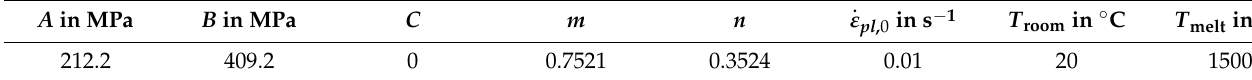
Figure 6. Extrapolated flow curves of HX220 for a plastic strain up to two ( a ); and comparison of the forming force– displacement curves from the experiments and simulation with average displacement at failure u x,fail ( b ). Table 2. Parameters of the Johnson–Cook hardening model for HX220.